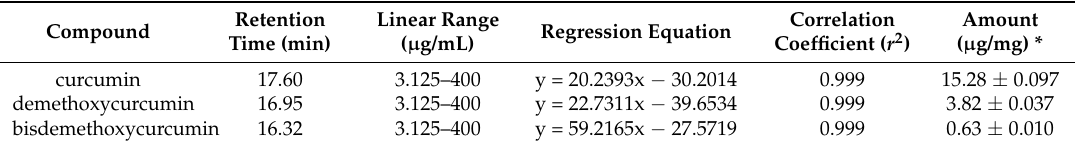
Table 2. The marker compound, linear ranges, regression equation, and correlation coefficient of the marker compounds in Curcumae Radix.